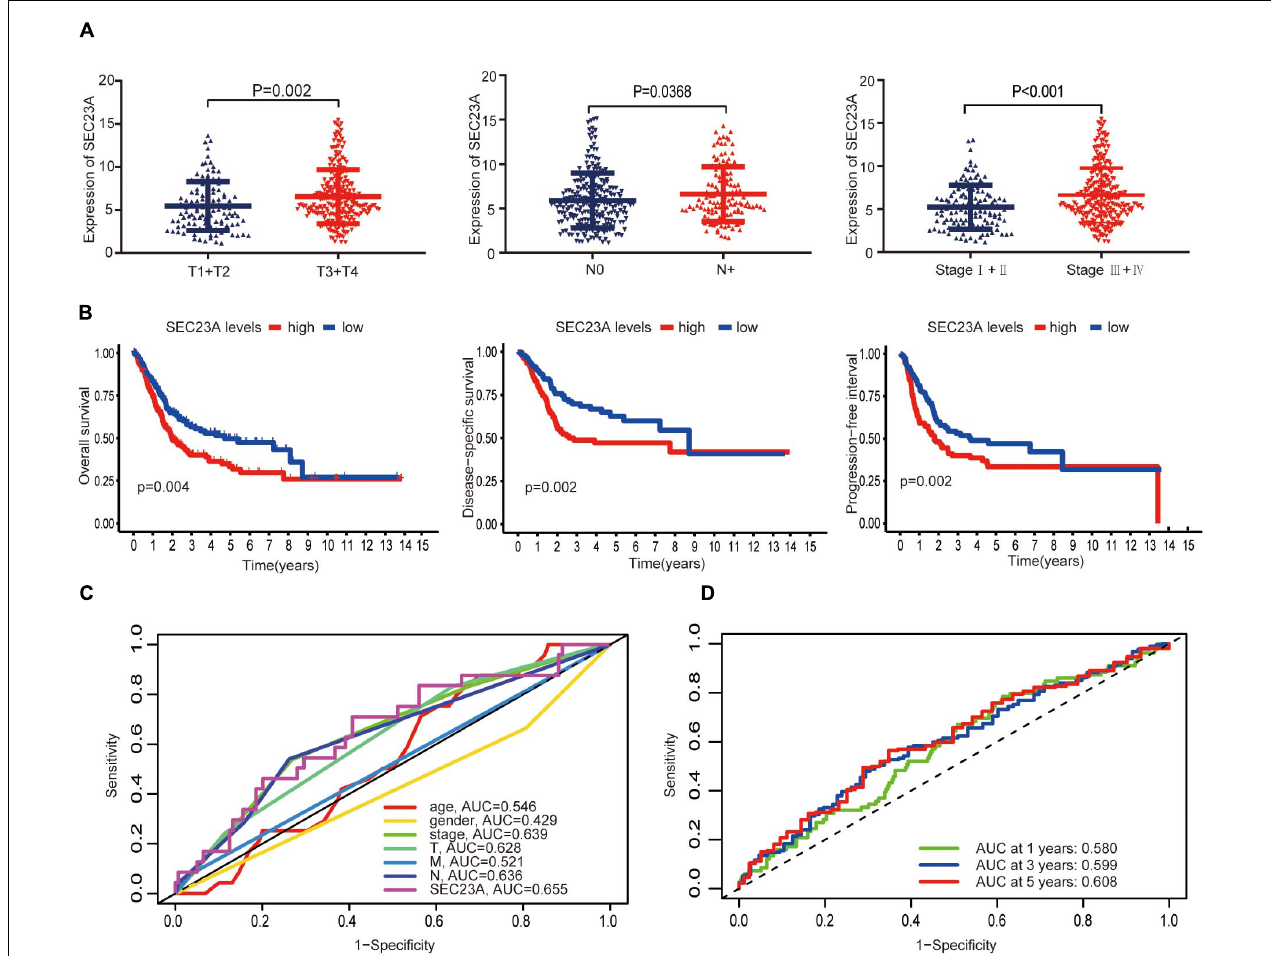
FIGURE 2 | Differential expression of SEC23A in bladder cancer and ROC analysis of SEC23A expression. (A) Association between SEC23A and clinical-pathological features. (B) Survival analysis of SEC23A (OS, DSS, PFI, and K-M analysis). (C) Multi-indicator ROC analysis based on SEC23A, with TNM stages, gender, and age. (D) Time-dependent ROC analysis on TCGA cohorts based on